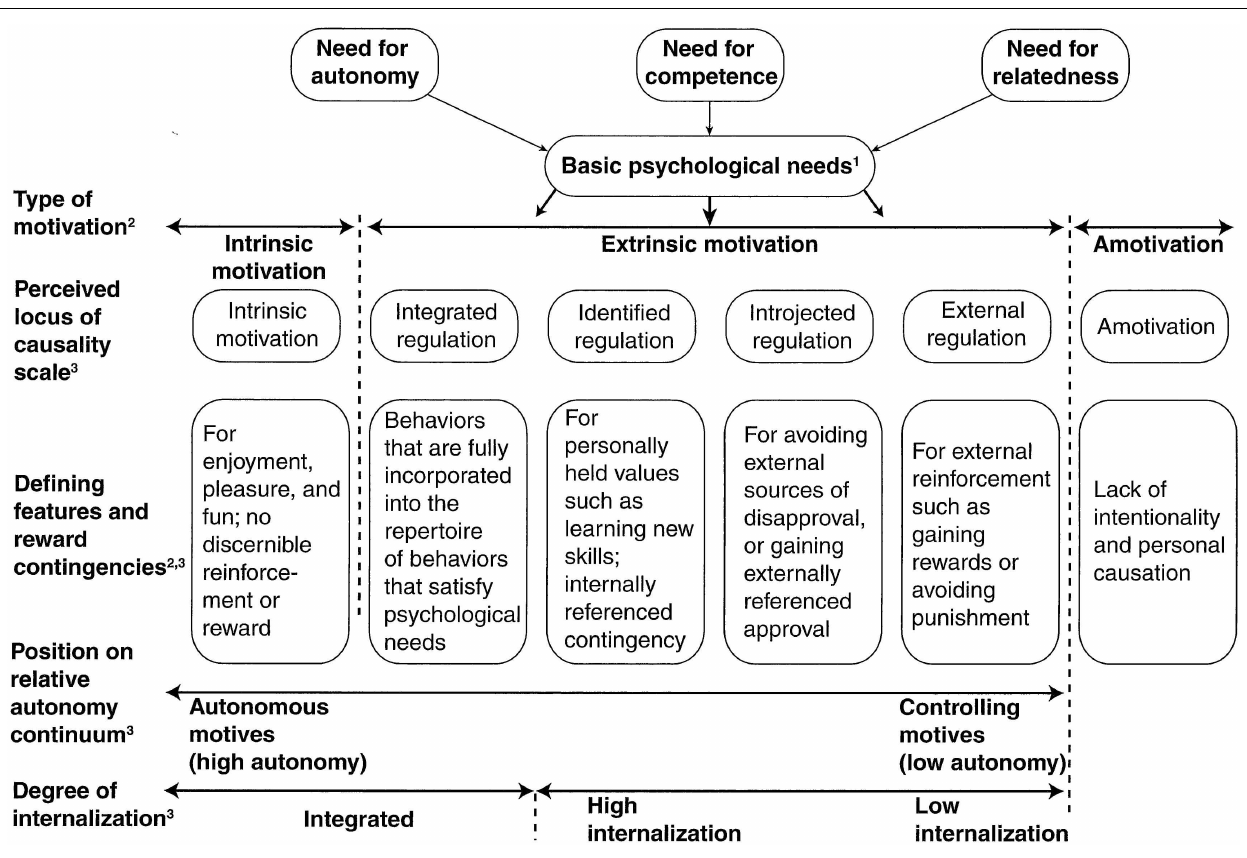
Frontiers in Psychology | Movement Science and Sport